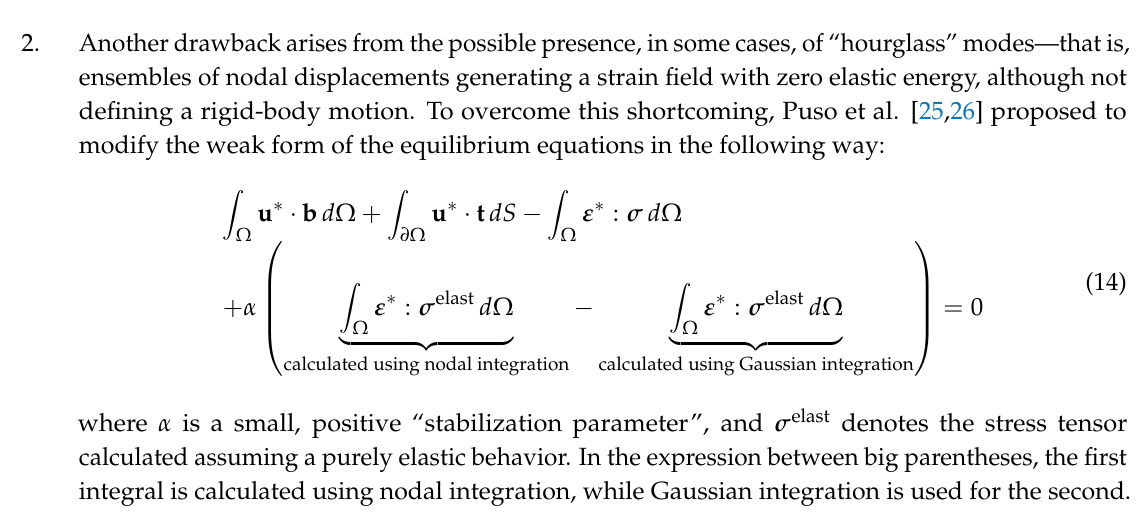
Figure 3. Couplings between a node and its first- and